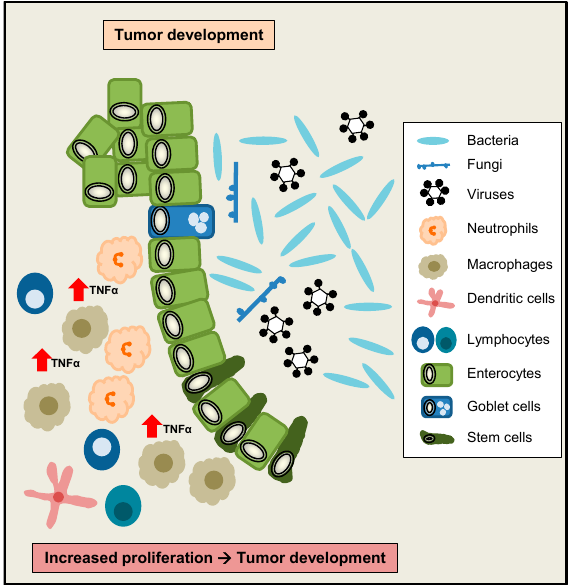
Figure 4. TNF α might induce intestinal tumour development. Elevated TNF α levels in the gut might contribute to colorectal cancer (CRC) and colitis-associated CRC development.